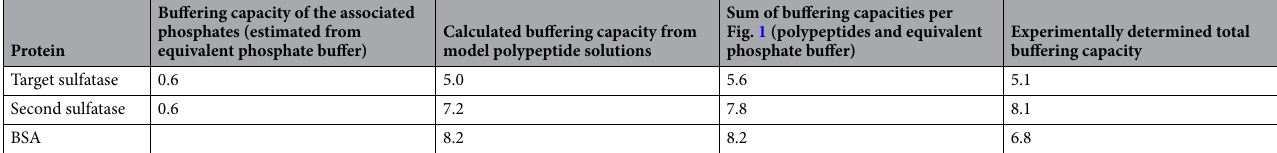
Table 3. Comparison of the experimental and calculated buffering